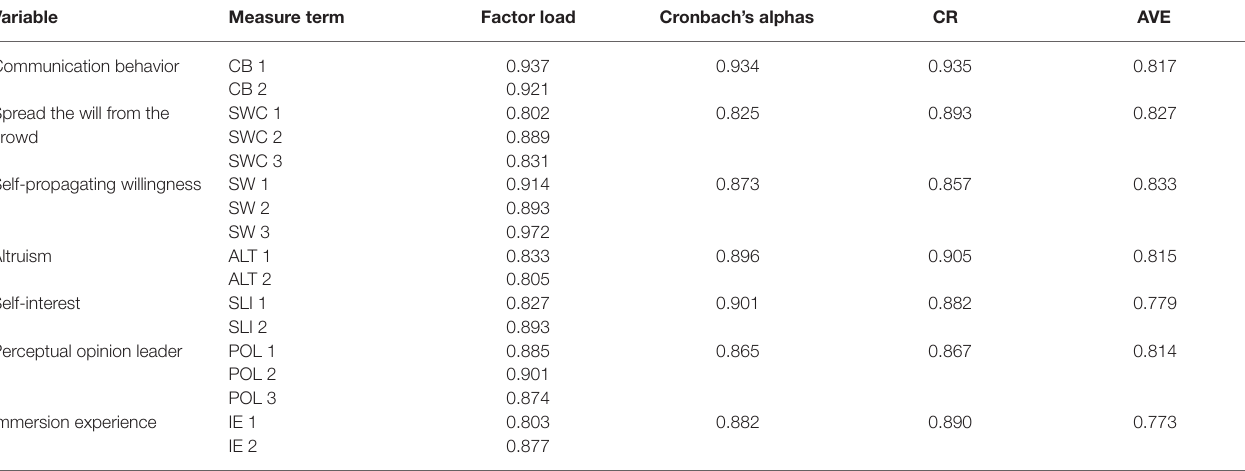
TABLE 1 | Factor load, α value, CR, and AVE.